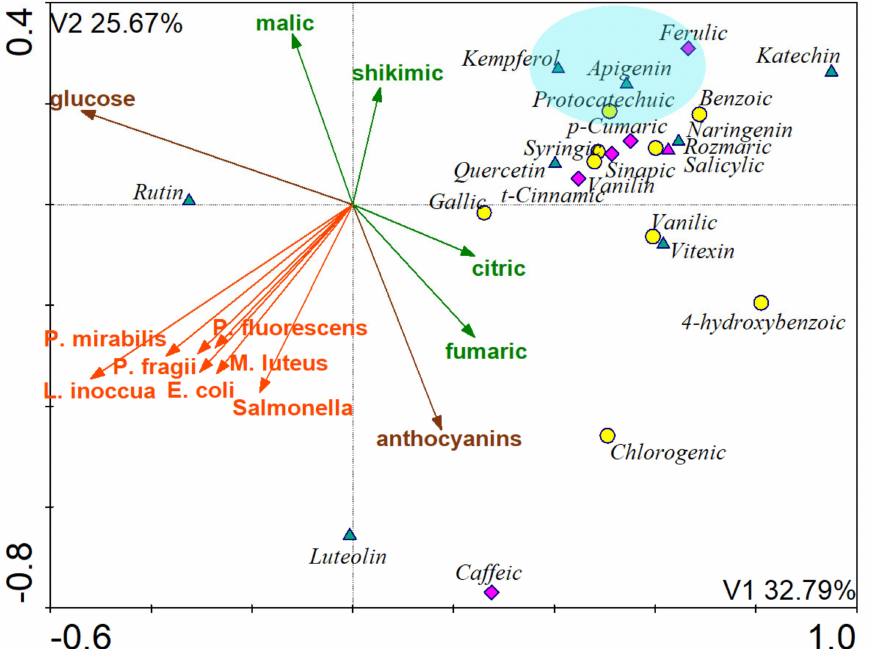
Figure 2. Canonical Correlation Analysis (CCA) ( n = 38) Dependencies between groups of phenolic acids, organic acids, pigments, sugars and their influence on the development of pathogenic and food spoilage microorganisms.